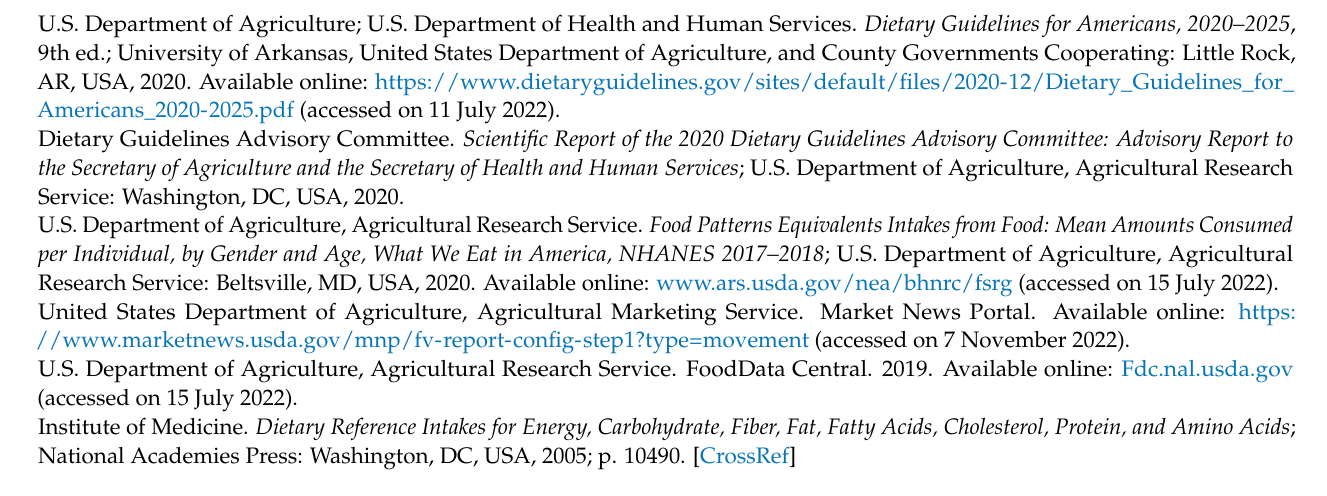
Table S5: Energy and nutrient intakes in adult watermelon consumers ( n = 792) and non-consumers ( n = 31,569), NHANES 2003–2018, gender combined